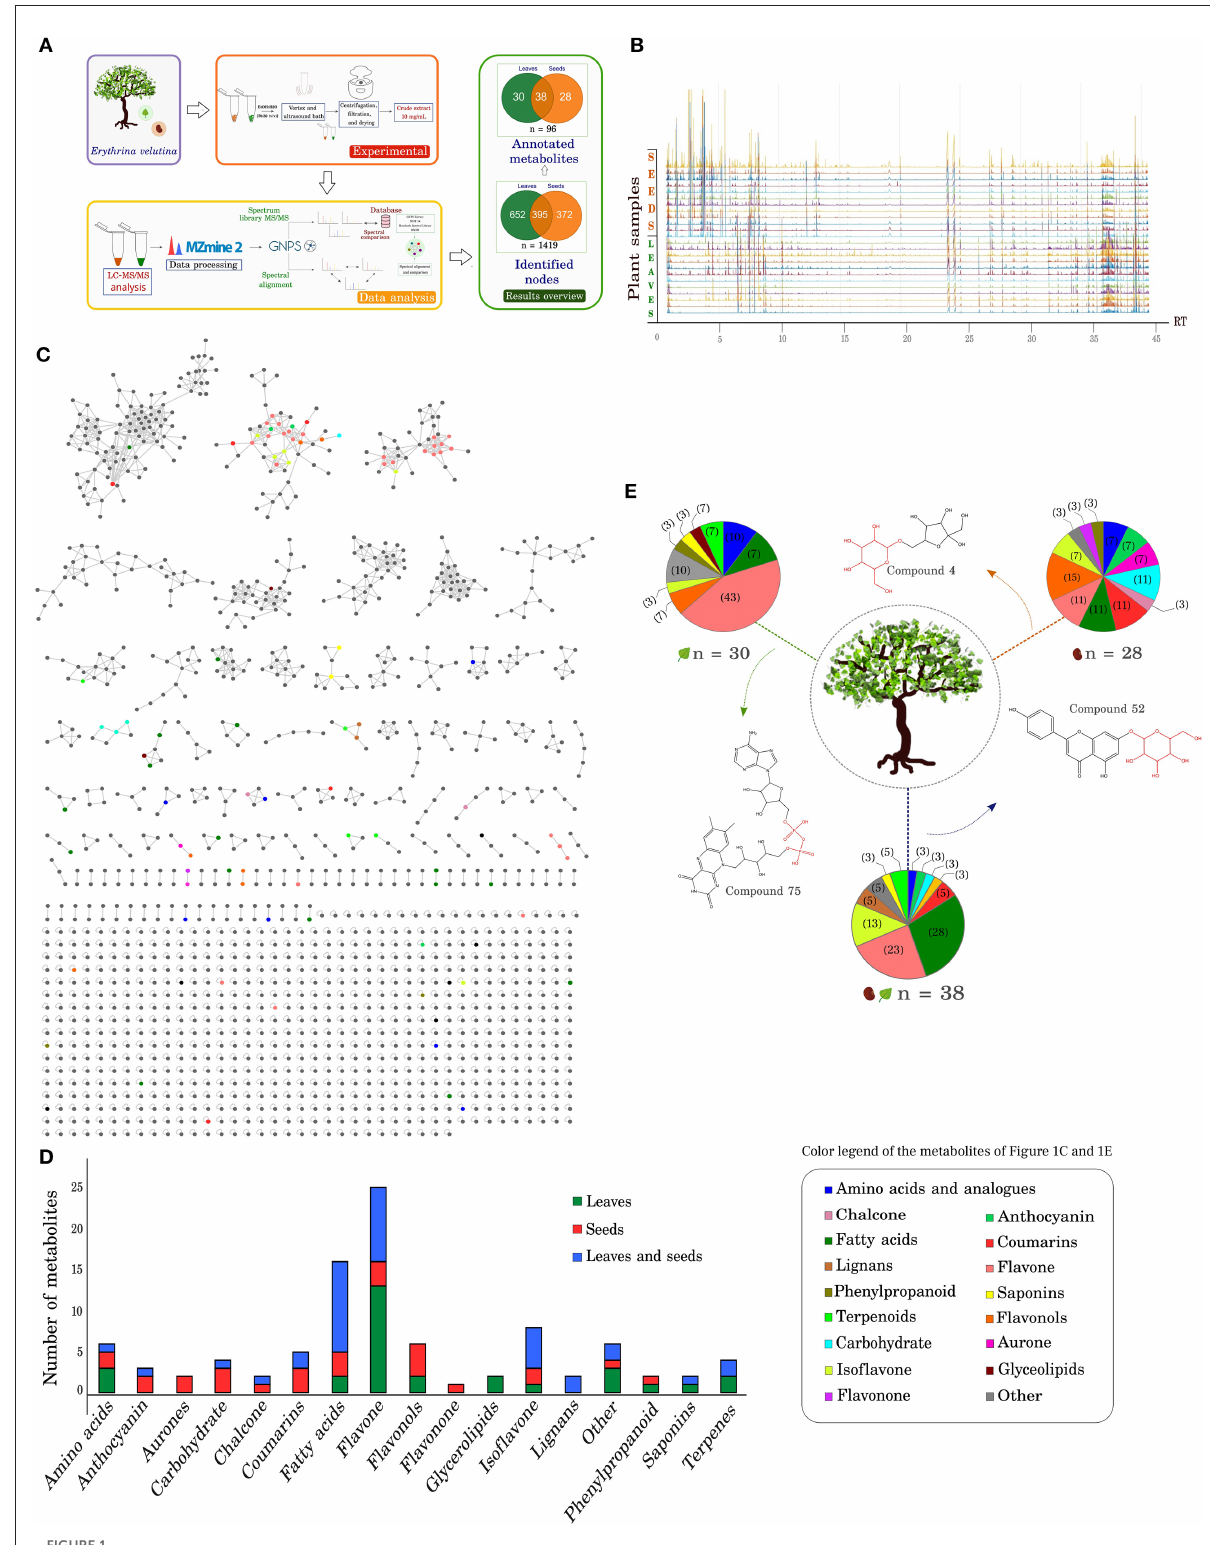
FIGURE1 Overview of the metabolic profile in leaves and seeds of Erythrina velutina . (A) Experimental procedure and data analysis by LC/MS. The metabolites number identified in the leaves and seeds are indicated in the Venn diagram, in green and orange colors, respectively.